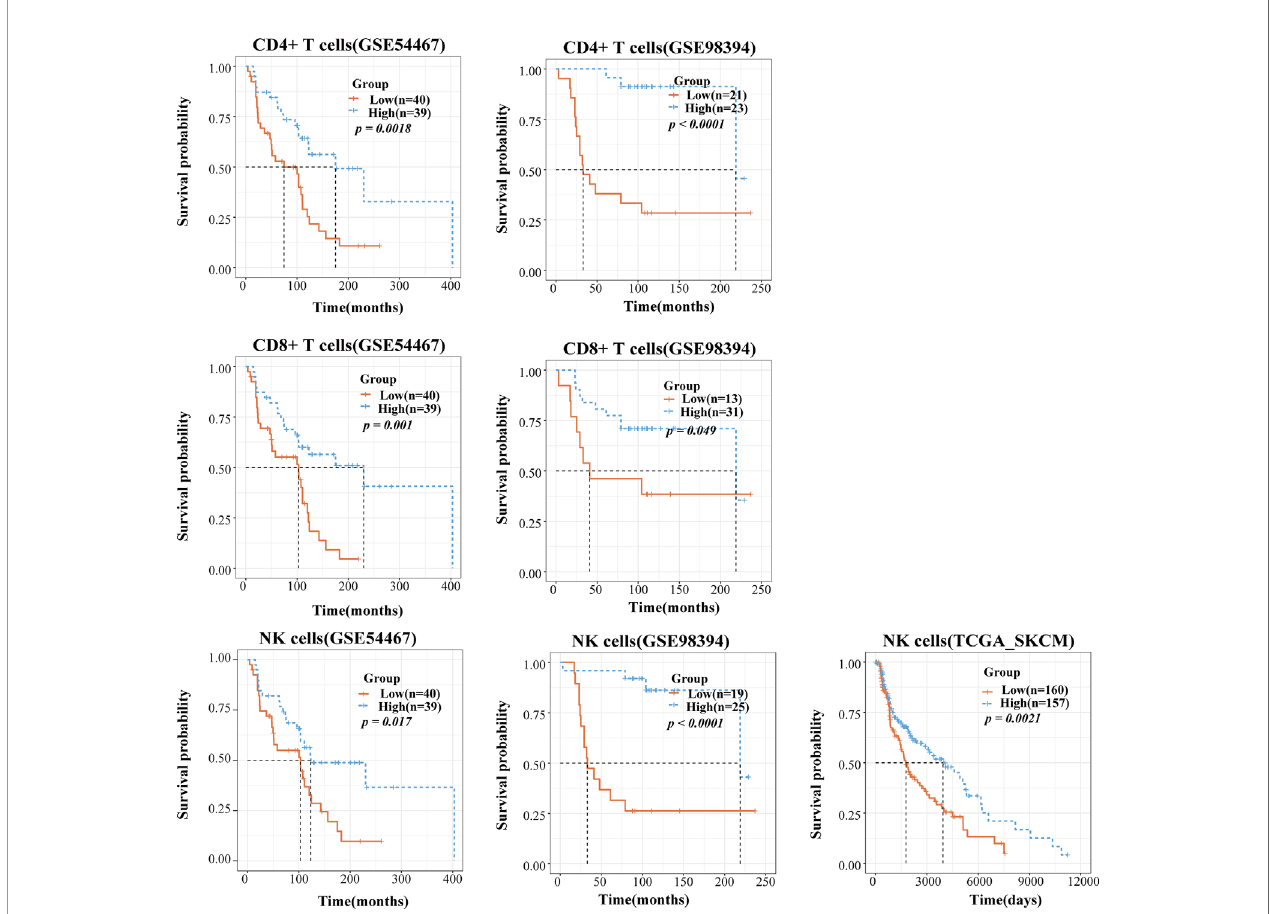
FIGURE 4 | The application of TICPE on prognostic analysis for melanoma. Survival high CD4+ T/CD8+ T/NK cells and low CD4+ T/CD8+ T/NK cells groups in melanoma patients, respectively. P values comparing two groups were calculated with the log-rank